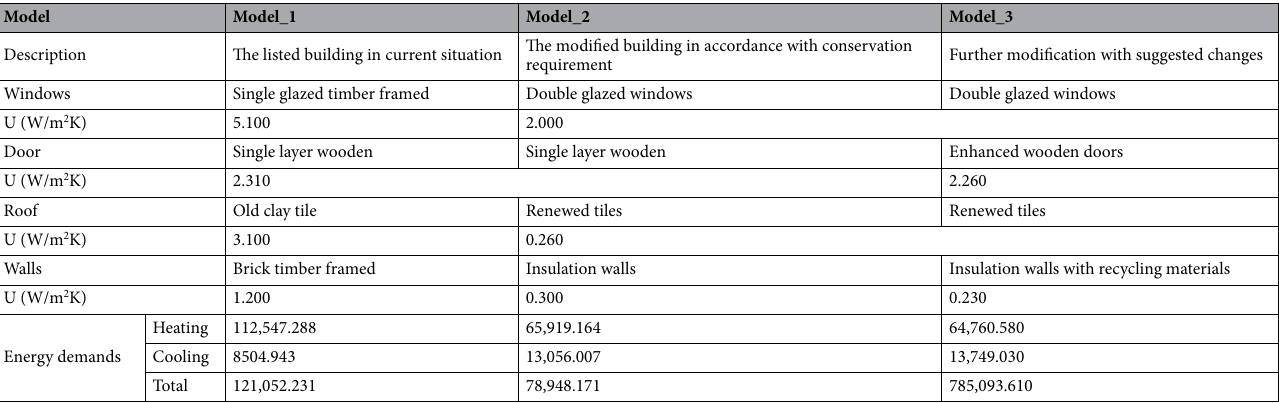
Table 3. Comparative review of the building envelope in terms of thermal protection and the annual energy demand, checked through simulation in the ZF case study